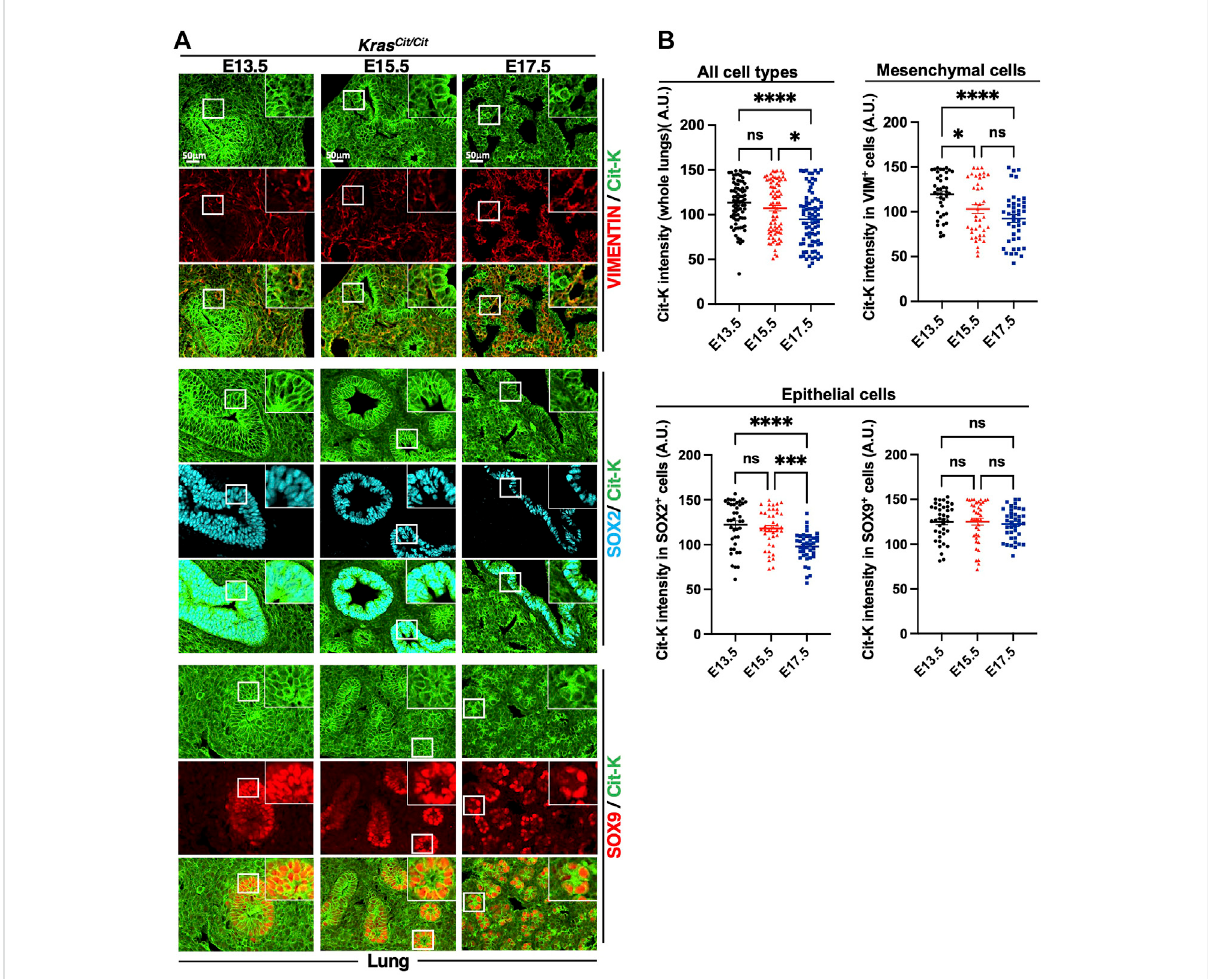
Cit-K is expressed in the developing lung. (A) Cit-K, VIMENTIN (VIM), SOX2 and SOX9 immunolabelling performed on lung sections of Kras Cit/Cit embryos at E13.5, E15.5 and E17.5. (B) Quanti fi cation by FIJI software of Cit-K signal intensity. One dot represents the mean of three measures of signal intensity of one cell. Data are represented as mean+/-SEM of 80 or 40 cells ( n = 4 embryos). Statistical signi fi cance was tested by Student ’ s t -test. *, p < 0.05; ***, p < 0.001; ****, p < 0.0001; ns, not signi fi cant. A.U. arbitrary